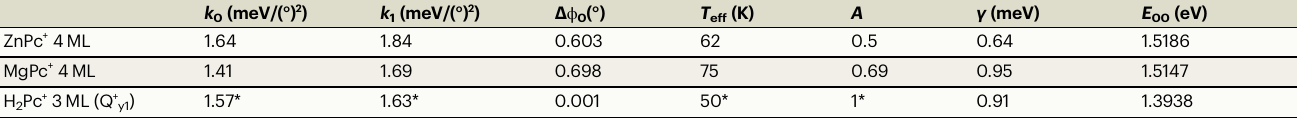
ParametervaluesforH 2 Pcdenotedbyanasterisk(*)were fi xed; k 0 and k 1 weretakenfromtheTD-DFTsimulationsand A wassettounity.For fi ttingoftheH 2 Pcspectrumminorcomponent,three additionalfreeparameters(notlistedinthetable)characterisingtheemissionpeak Q y2 + ofthesecondtautomerwereused:relativeintensity I =0.29,FWHMofdressingfunction γ 2 =0.31meVand mutualenergyseparation of the tautomers Δ E 00 =1.17meV.